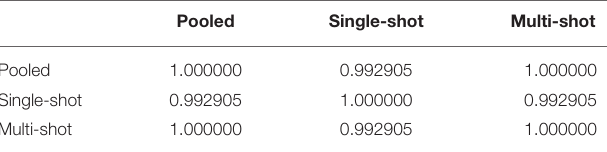
TABLE 1 | Correlation between SSE from pooled, single-shot and multi-shot regression.